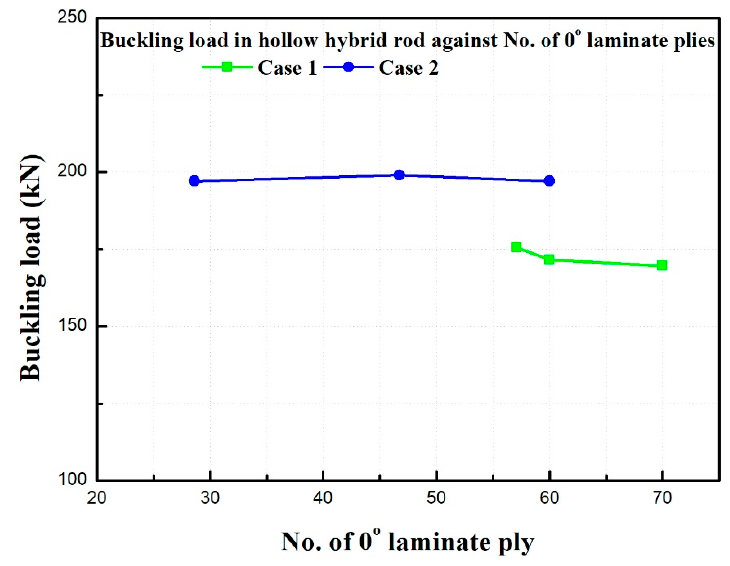
Figure 16. Change in buckling load as a function of percentage of 0° ply laminates used in CFRP.